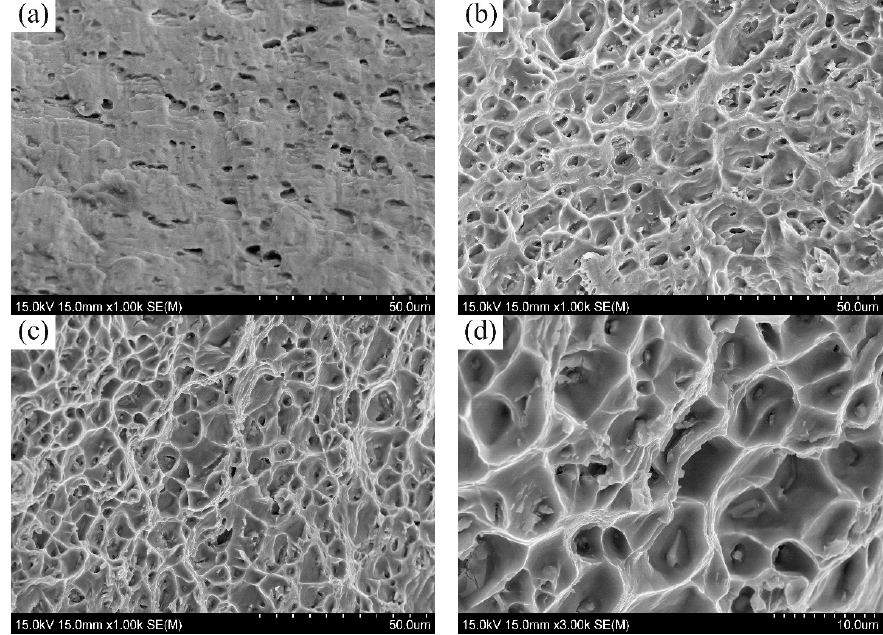
Figure 8. SEM images of the fractography of 5083 weld joints prepared with: ( a ) Al-5Mg, ( b ) 2 wt% TiC p / Al-5Mg, ( c ) 4 wt% TiC p / Al-5Mg and ( d ) higher magnification image of ( c